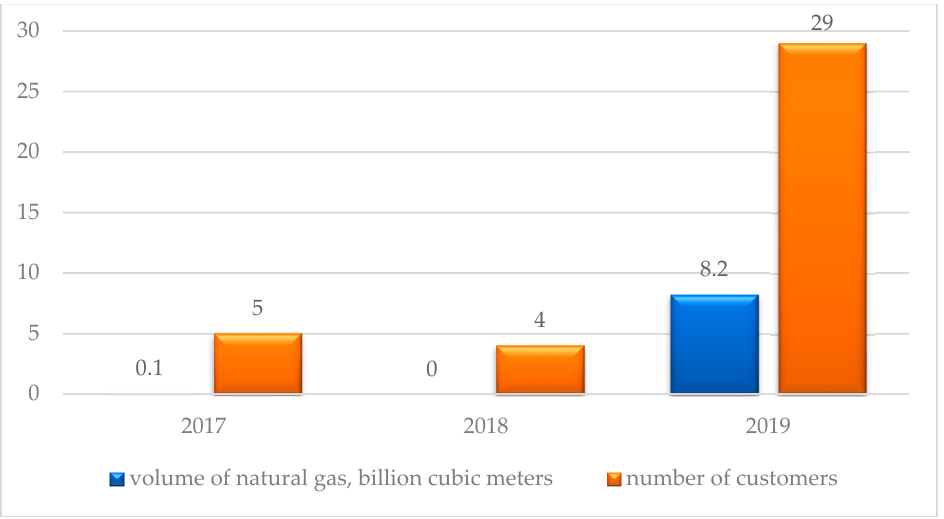
Figure 8. Dynamics of the provision of the “Customs warehouse” service in 2017–2019. Source: [54] (p. 93).